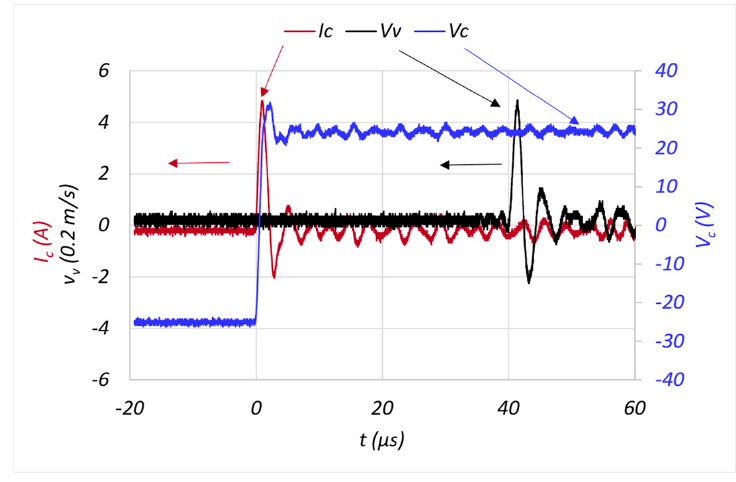
Figure 14. Measured raw data seen on the oscilloscope screen showing the transient current, vibration velocity and voltage waveforms. Vibration velocity values have a gain of five.